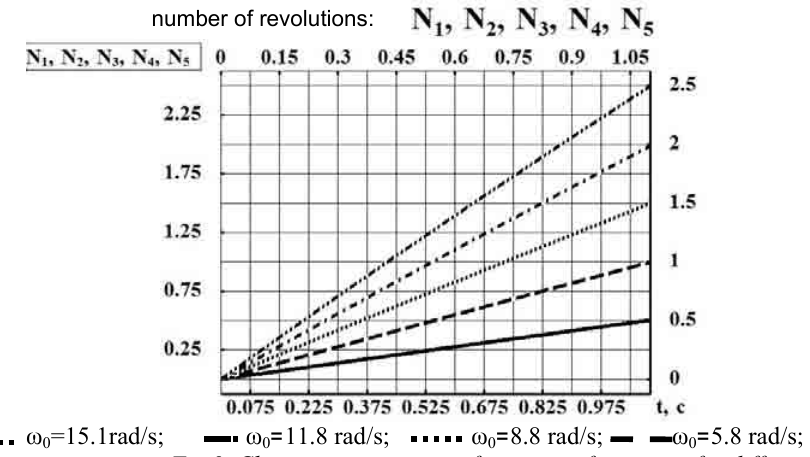
Fig.9. Characteristic curves of quantity of rotations for different values of initial angle speeds of